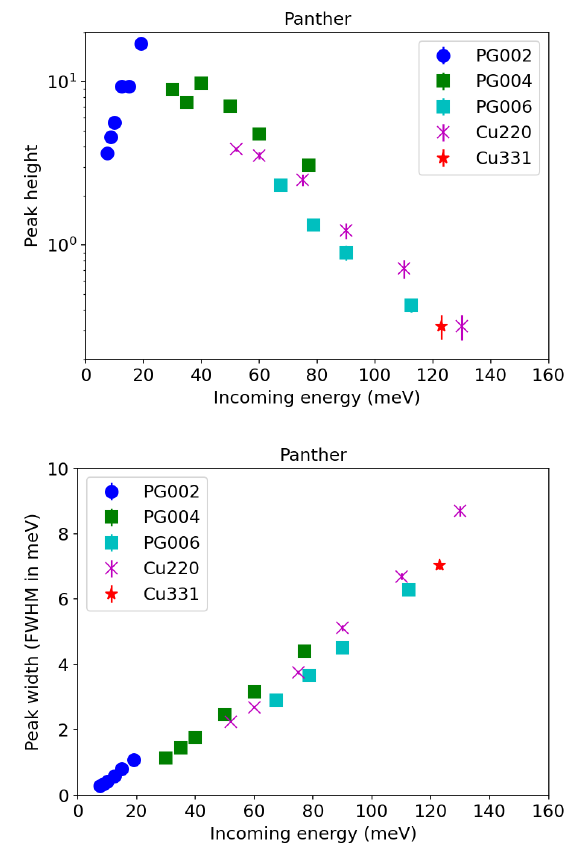
Figure 2. Peak intensity (top) and elastic energy resolution (bot- tom) on Panther from vanadium